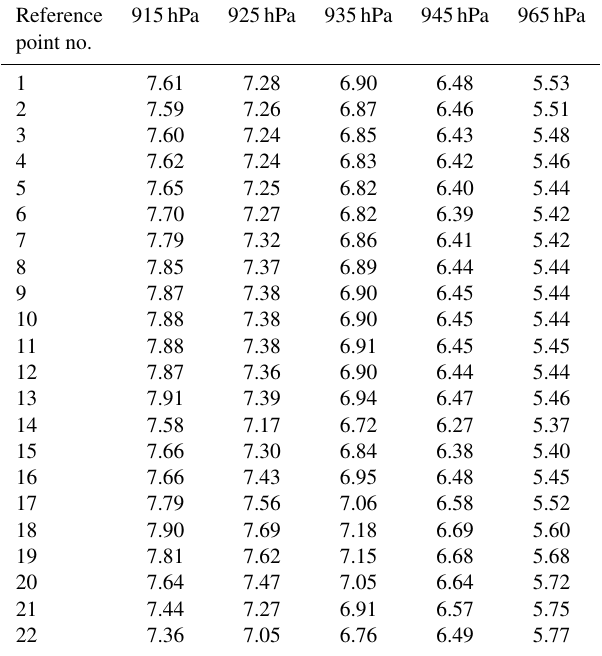
Table 5. Statistical results of maximum water level associated with unfavorable tracks of typhoons under different intensity